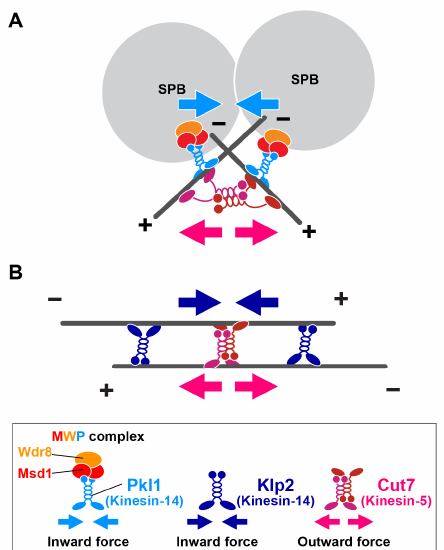
Figure 1. Generation of collaborative inward forces by the two Kinesin-14s, Pkl1 and Klp2. ( A ) When spindle bipolarity starts to be established upon onset of mitosis, spindle pole body (SPB)-tethered Pkl1 (the MWP complex) engages with the spindle microtubule that emanates from the opposite SPB. Minus end-directed motility of Pkl1 generates an inward force (blue arrows). This pulling force antagonises an outward force exerted by Cut7 (red arrows) that is also localised in the vicinity of the SPB and promotes interdigitation of the microtubules emanating from the two SPBs. In addition to inward force generation, the MWP complex plays a crucial role in anchoring the minus end of the spindle microtubule to the mitotic SPB as a barrier [32]. ( B ) Once bipolar spindles are formed, Klp2 and Cut7 are localised on antiparallel microtubules. These two kinesins antagonistically generate an inward force (blue arrows) and an outward force (red arrows), respectively. + and – stand for the microtubule plus and minus ends, respectively. Note that Cut7 is reportedly localised to the two other sites. One is a medial microtubule contact site. This localisation is seen when bipolar spindles are depolymerised first and then allowed to repolymerise; Cut7 promotes interpolar bundle formation [39]. The other site is the kinetochore, to which Cut7 is recruited when chromosomes are misaligned. Under this condition, Cut7 is required for chromosome gliding towards the spindle equator [40].